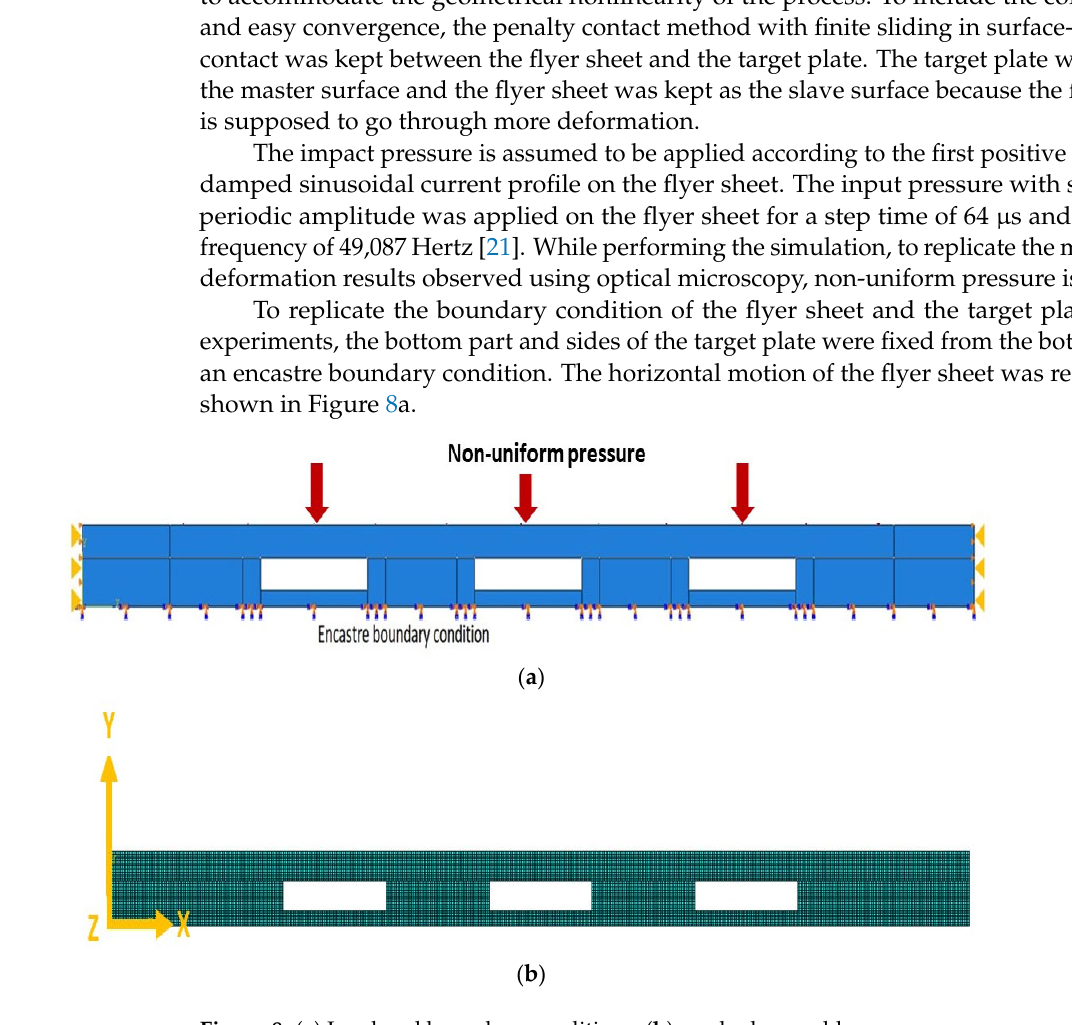
Figure 8. ( a ) Load and boundary conditions, ( b ) meshed assembly. A total of 10,470 linear quadrilateral elements of type CPS4R elements were used for the meshing. The CPS4R element is a four ‐ node bilinear plane ‐ stress quadrilateral, re ‐ duced integration, hourglass control element. The reduced integration uses a lesser num ‐ ber of Gaussian coordinates and produces a less stiff element which results in reduced computation time. Enhanced hourglass control was used to control the hourglassing of the element caused due to one integration point at the centre of the element during the use of reduced integration. 3. Results and Discussions 3.1. Mechanical Properties Evaluation of Joints 3.1.1. Energy Optimization for Joints The joints were generated by the EMJ process with variable discharge energies of 7, 8, 9, and 10 kJ. A photograph of the generated joints is shown in Figure 9. The character ‐ istics of each joint were recorded and are shown in Table 3. It is found that the optimal discharge energy of 8 kJ is required for making all three joints successfully. Discharge energy less than 8 kJ resulted in insufficient forming of the flyer which led to no joining at the central region of the spot. When an energy greater than 8 kJ was used, excessive forming of the flyer occurred, which led to shearing of the joint boundaries. Table 3. Visual inspection of the joint produced by EMJ at different discharge energies. Discharge Energy